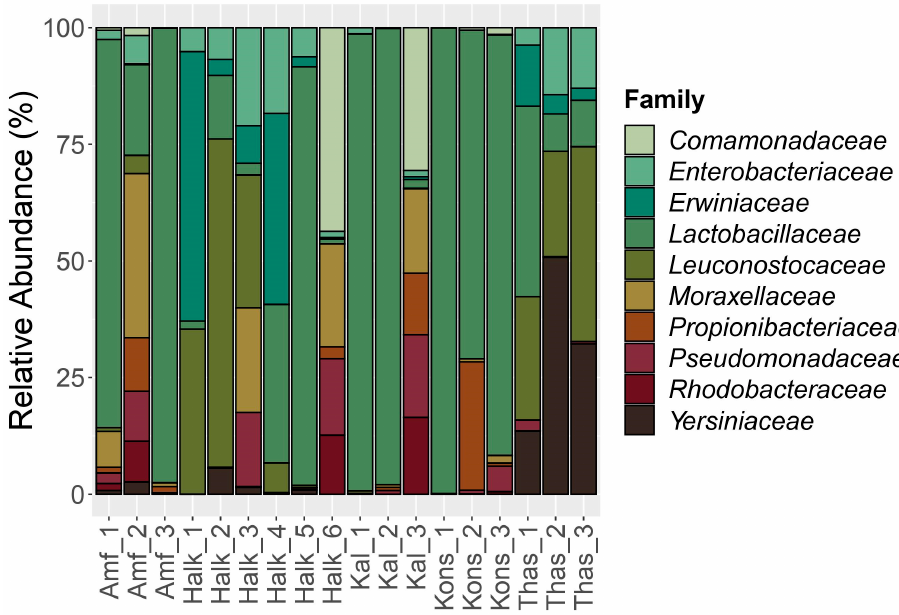
Figure 1. Distribution of the major bacterial families detected in the samples. The scale in the y-axis reflects the normalized relative abundance percentages (%).